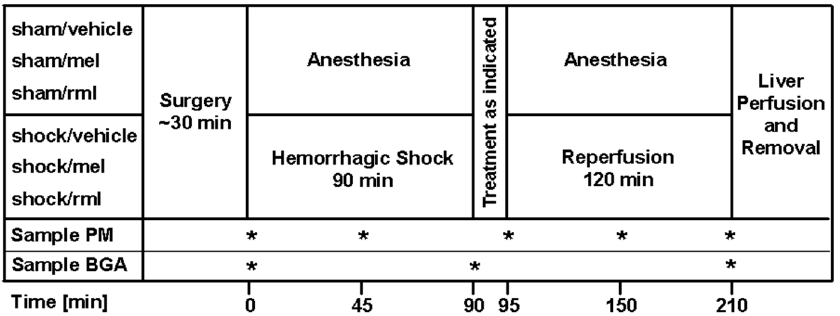
Figure 1. After the induction of anesthesia, groups were treated as indicated ( n = 8 per group). Samples for blood gas analyses (BGA) and plasma melatonin content (PM) were taken at the times marked with an asterisk. rml = ramelteon; mel =